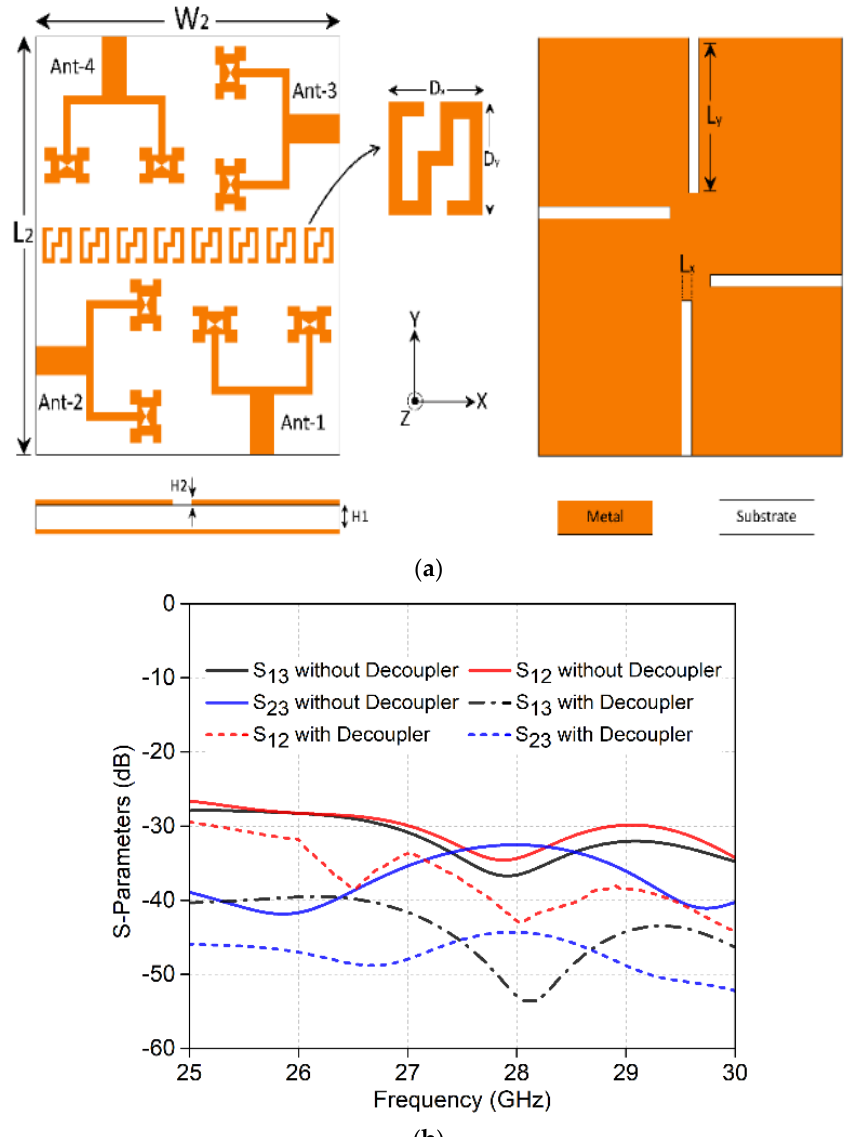
Figure 6. ( a ) Final proposed antenna with decoupler and DGS; ( b ) Transmission coefficient results with and without decoupler and DGS.